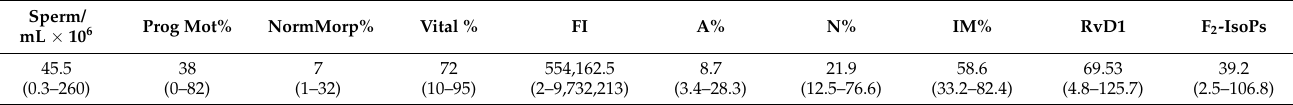
Table 1. Medians and Interquartile ranges (IQR) of all variables in 85 individuals. Sperm/ mL × 10